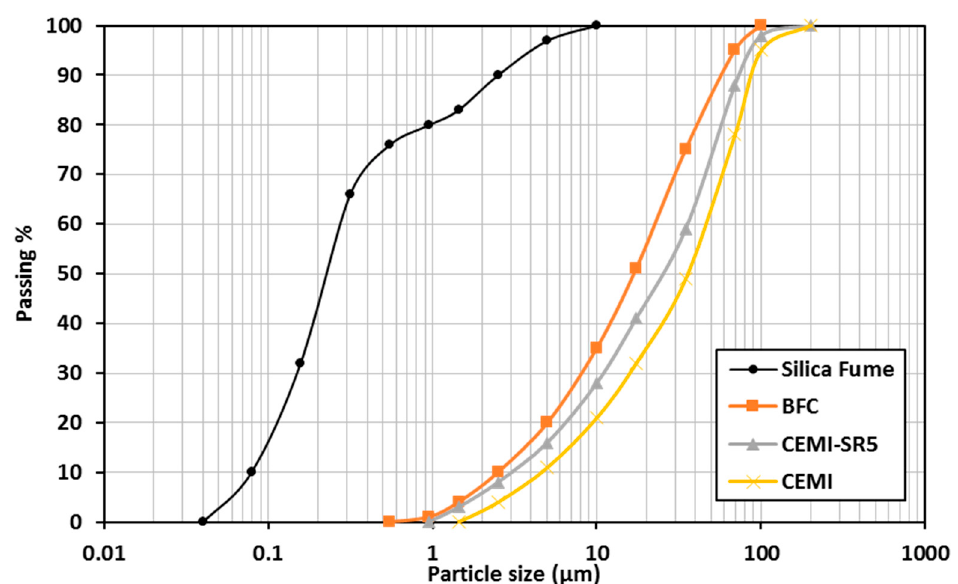
Figure 1. Particle size distribution of the binder used.